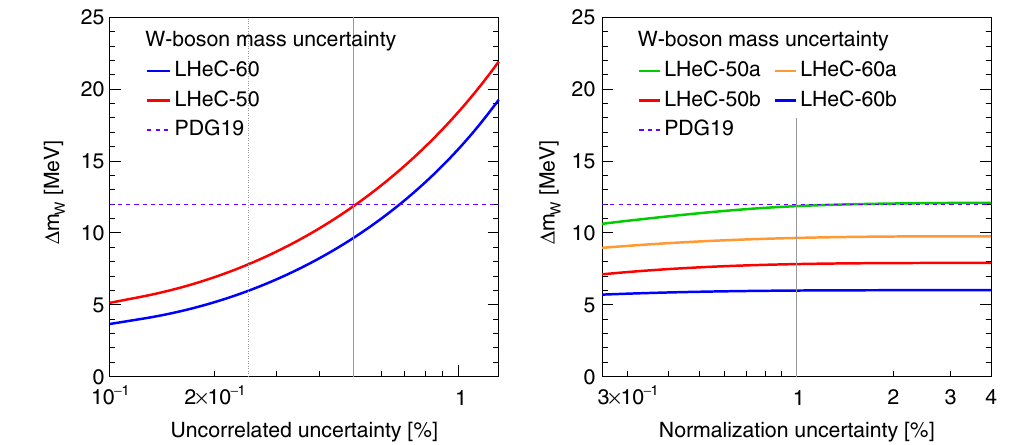
Fig. 3 Left: The total uncertainty (cid:2) m W as a function of the size of the uncorrelated uncertainty. The horizontal line marks the uncertainty of the present world average. The ‘a’ scenarios LHeC-60a and LHeC-50a (uncorrelateduncertaintyof0.5 %)andthe‘b’scenariosLHeC-60band LHeC-50b (0.25 %) are indicated by vertical lines. Right: The uncer-